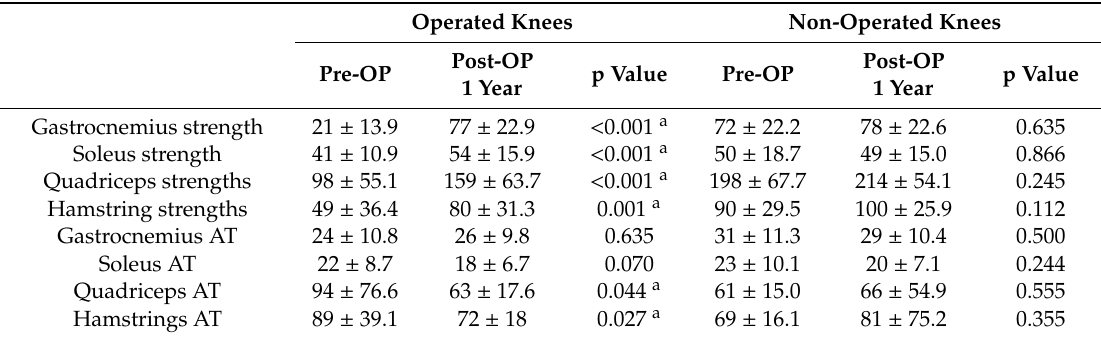
Table 2. Muscle strength and acceleration time of both knees before and one year after anterior cruciate ligament (ACL) reconstruction of one knee.